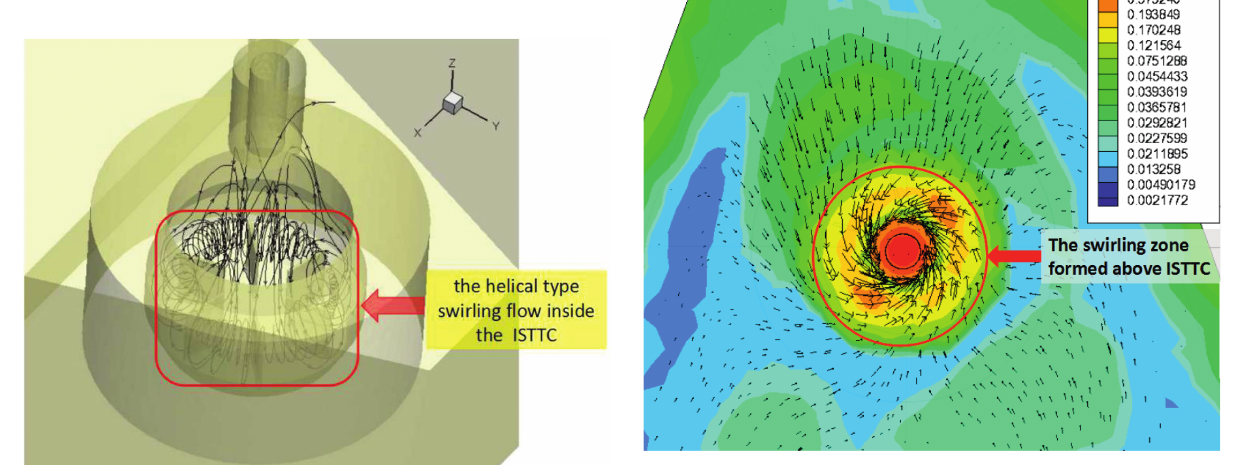
Figure 6: The stream line diagram of flow field in impact zone of tundish with ISTTC.